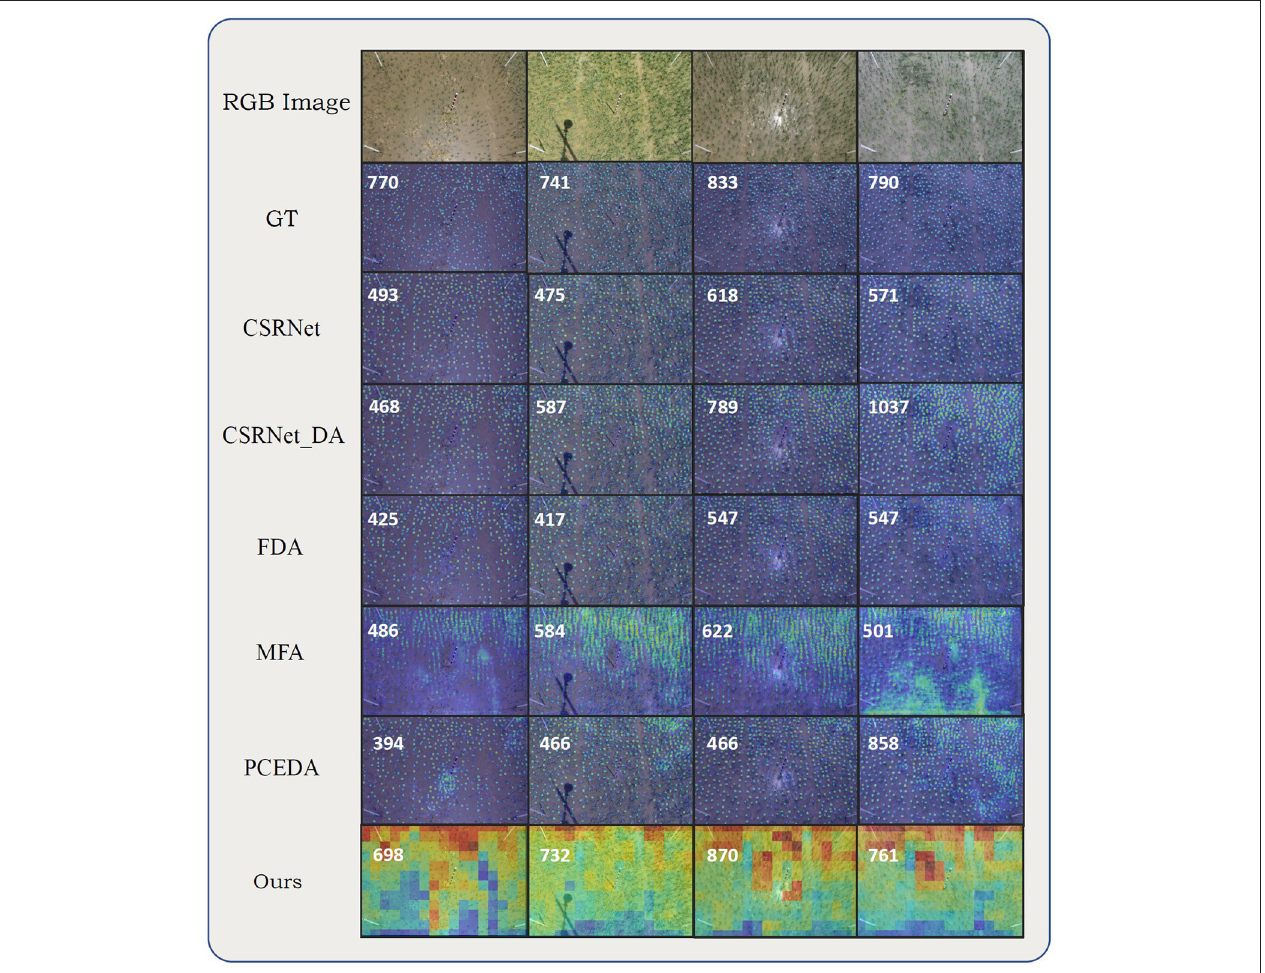
FIGURE 7 | Visualizations on RPC dataset. From top to bottom alternating: RGB image, ground truth density map, density maps (count maps) predicted by CSRNet, CSRNet DA, FDA, MFA, PCEDA, and our method. Numbers on the upper left corner of the estimated density maps (count maps) represent the ground-truth or predicted counting value